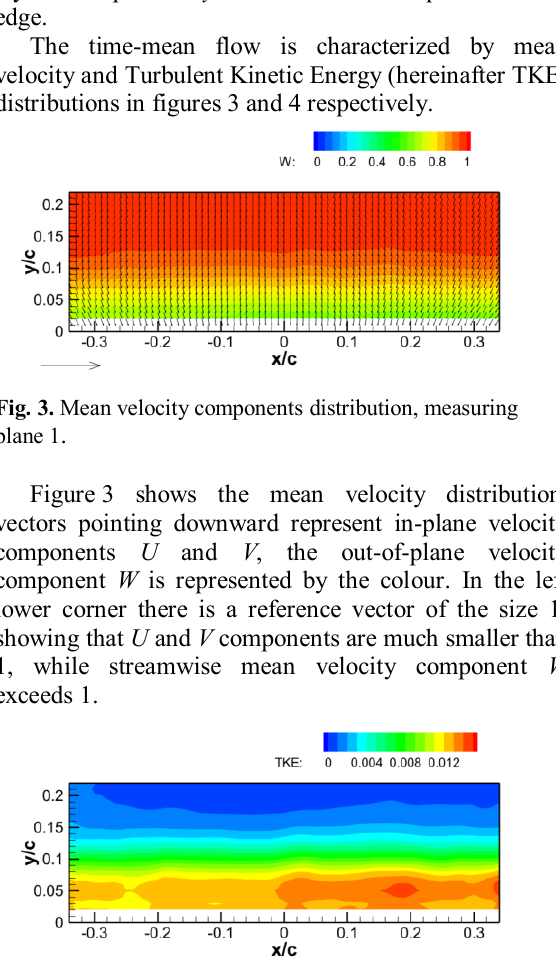
Fig. 4. TKE distribution, measuring plane 1